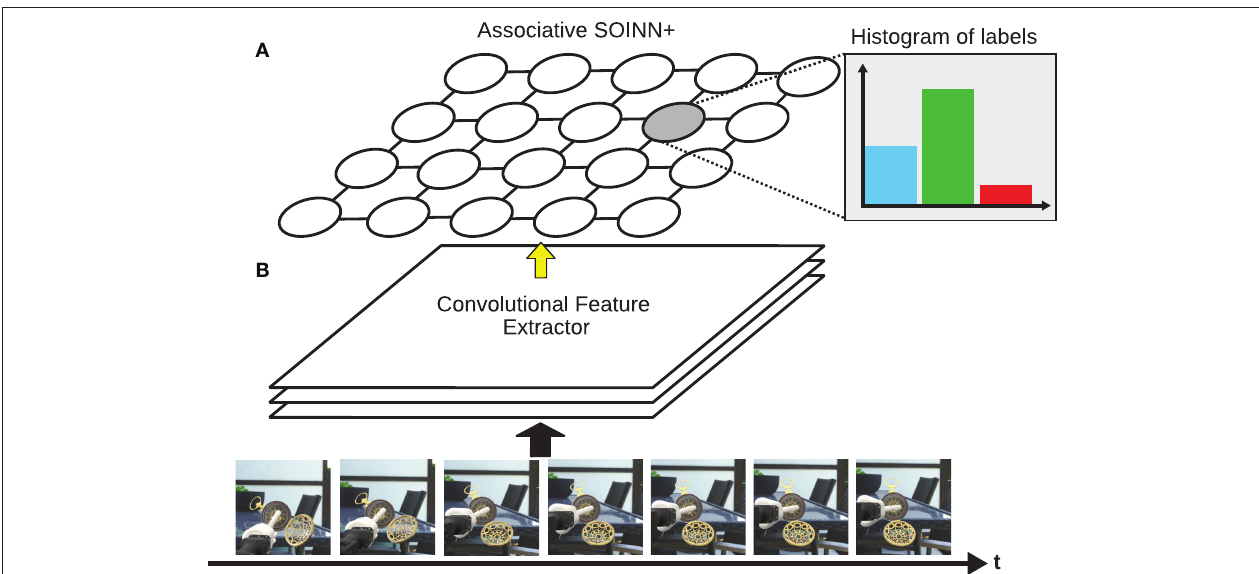
FIGURE 1 | This figure shows an illustration of the A-SOINN+ (A) and the feature extractor (B) . Over time, different frames become available. These are fed into the feature extractor, illustrated by the thick, black arrow. The feature extractor creates feature vectors representing the image frames. These feature vectors are fed into the A-SOINN+ model afterward, illustrated by the thin, yellow arrow. The proposed model stores a histogram of input labels for each node to facilitate classification, shown for one node in the top right corner. This figure is inspired by the GDM illustration of Parisi et al. (2018). The 3D object is a derivative of “Antique Pocket Watch” by “michael_grodkowski” licensed under CC BY